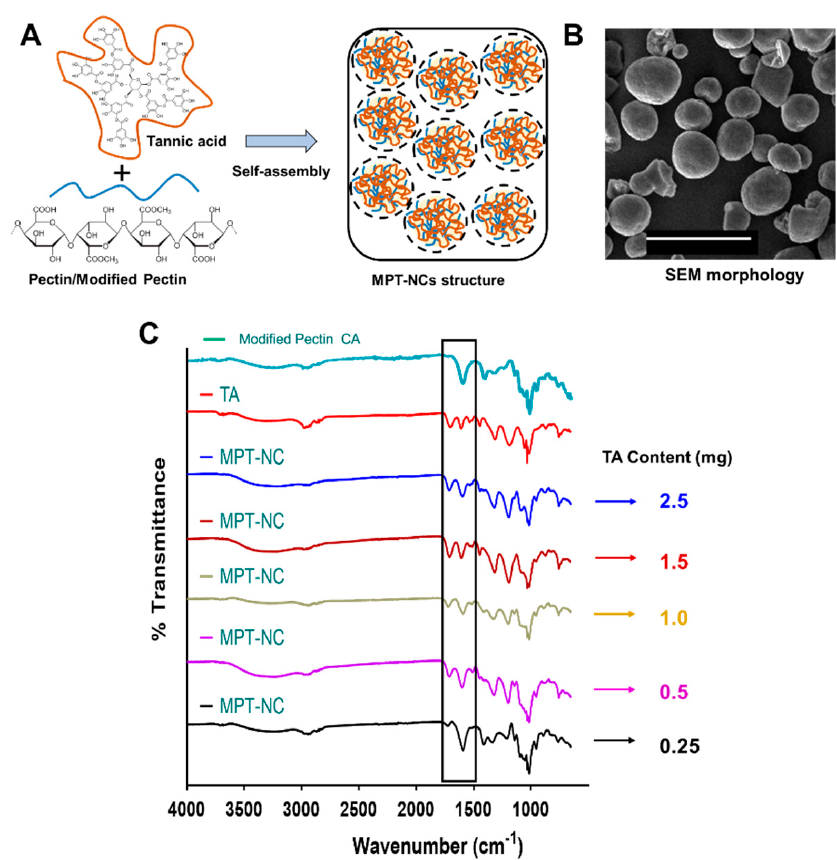
Figure 2. Confirmation of the formation of nanocomplexes based on modified pectin and tannic acid (MPT-NCs). ( A ) Schematic representation of the self-assembly formation process for producing modified pectin-tannic acid nanocomplexes. ( B ) Representative scanning electron microscopy image of MPT-NCs. Direct magnification 10,000 × . ( C ) ATR-FTIR spectra of modified pectin, TA, and